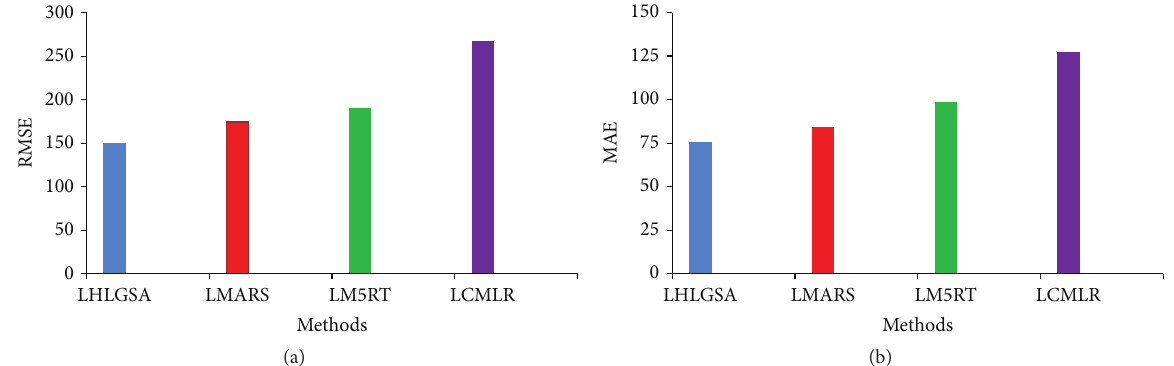
Figure 11: Overall errors of forecasted river flow using all log models for Shyok catchment.